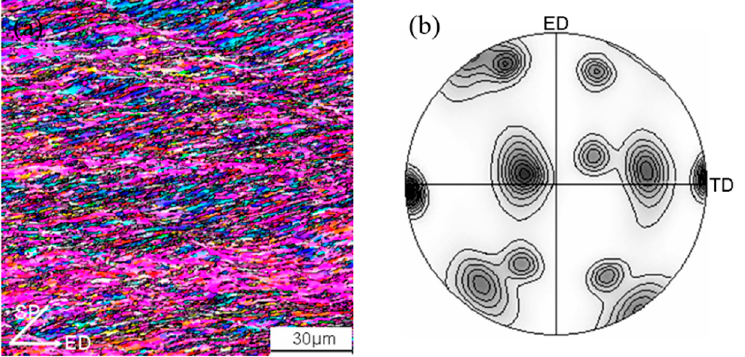
Figure 6. ( a ) EBSD map and ( b ) (111) pole figure, showing the formation of a fibre microstructure and textures developed after 3rd pass